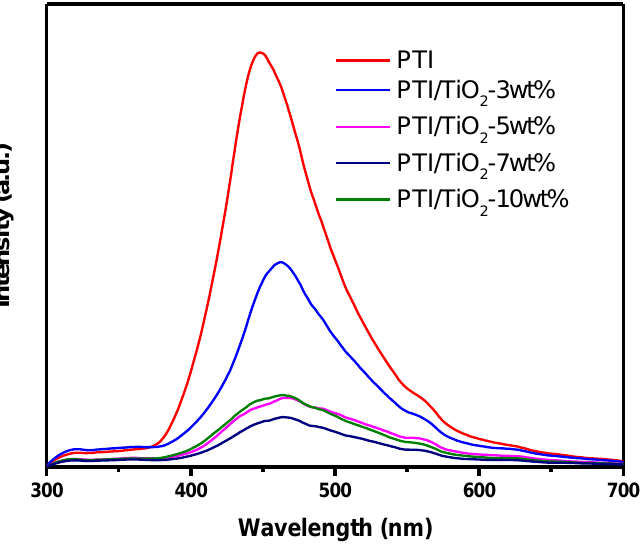
Figure 4. Photoluminescence spectra of as-prepared samples.